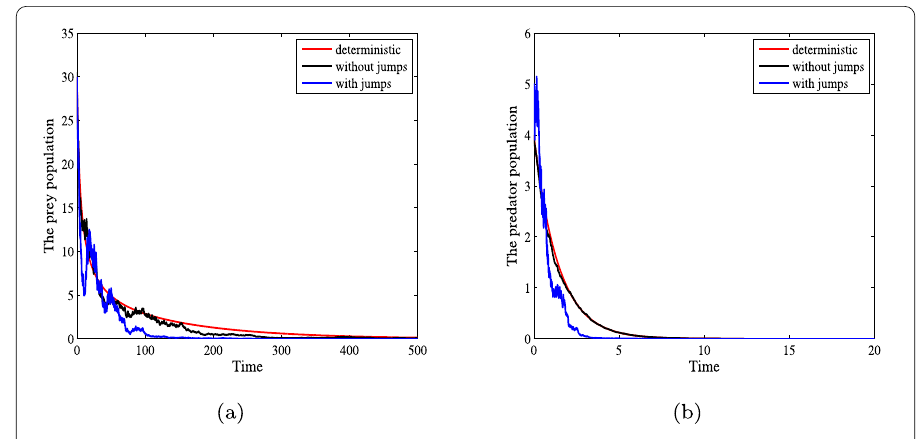
Figure 2 Deterministic and stochastic trajectories of prey population and predator population with parameters in Table 1. Moreover, α = 0.01, A 1 = 20 σ 2 1 = σ 2 2 = 0.005 and γ 1 ( u ) = γ 2 ( u ) = 0.05. ( a ) Trajectories of